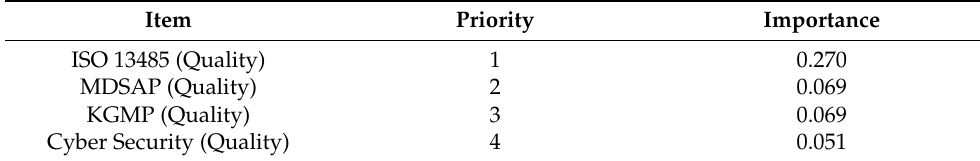
Table 5. Results of quality readiness.